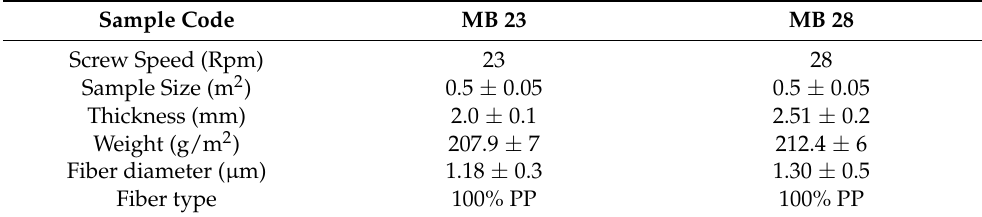
Table 2. Meltblown Samples